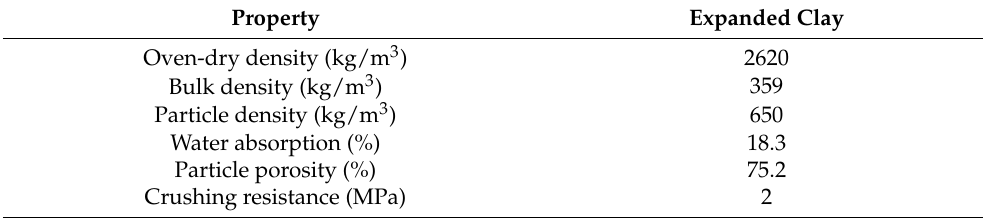
Table 2. Properties of LWA (expanded